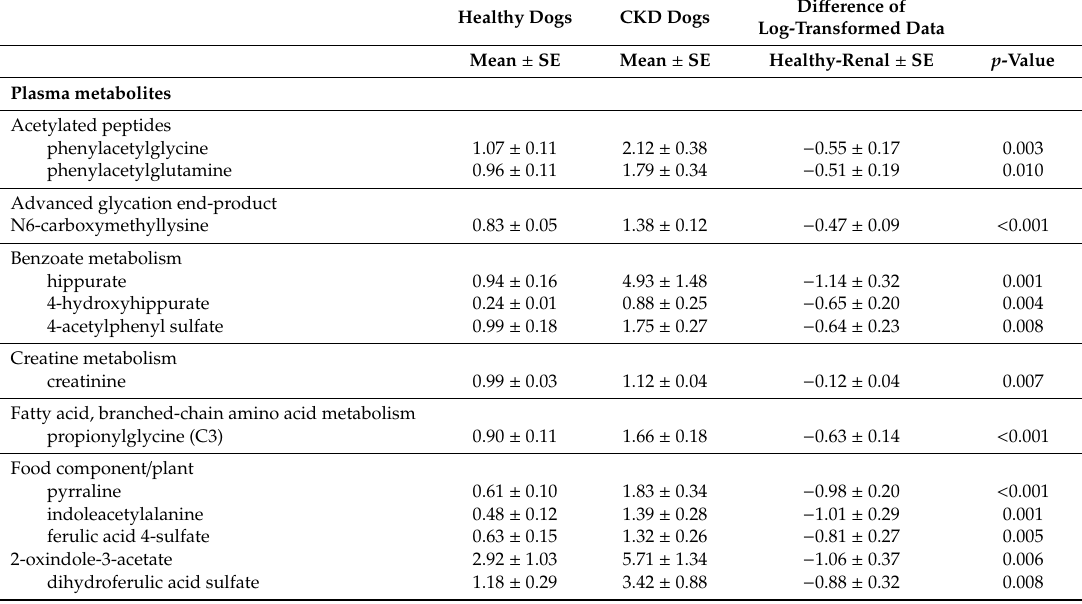
Figure 1. Principal components analysis for metabolomics data at baseline from ( a ) plasma and ( b ) feces from healthy dogs (black) and dogs with early stage renal disease (red) with circles indicating 95% confidence intervals. Table 3. Differences in plasma and fecal metabolites between healthy dogs and dogs with early renal disease at baseline.